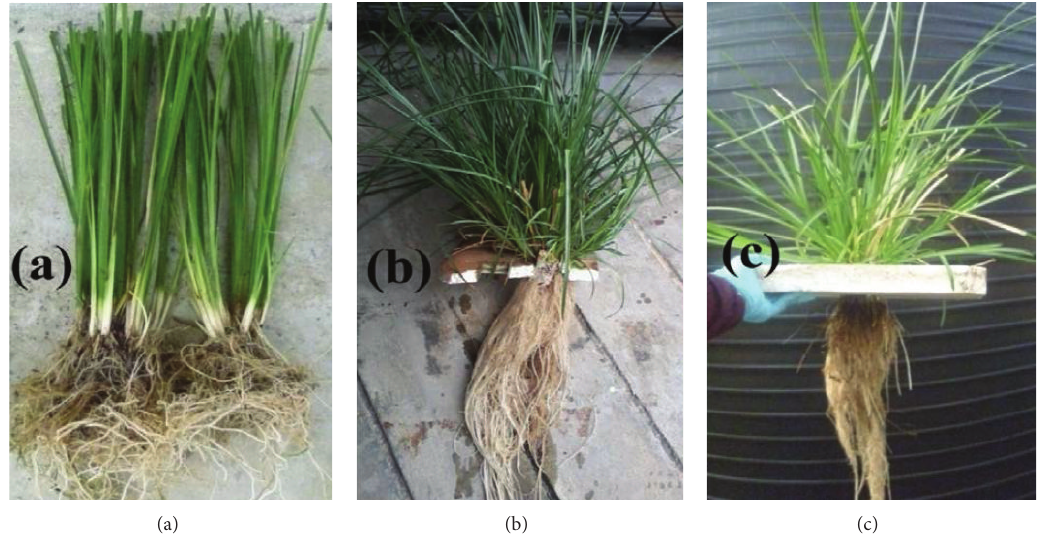
Figure 9: Vetiver growing on POME: (a) Vetiver starting day, (b) low concentration POME, and (c) high concentration POME.